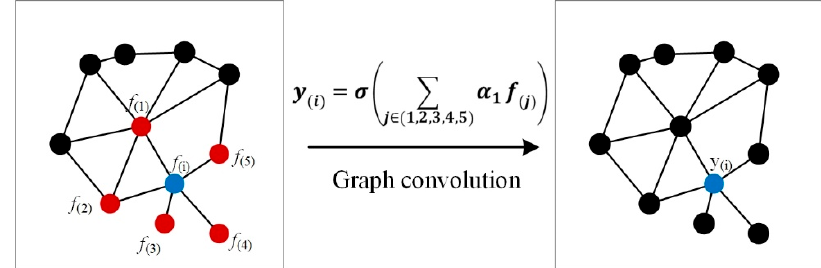
Figure 2. Procedure for capturing spatial dependency by graph convolution for K = 1 (using only one vertex as an example). K is the kernel size of the graph convolution, which determines the maximum radius of the convolution from central nodes, α 1 is the convolution kernel parameter, σ is an activation function (i.e., rectified linear unit (ReLU)), y ( i ) indicates the passenger flow volume of vertex i to be predicted, and each f ( j ) indicates the historical passenger flow volume of vertex j .